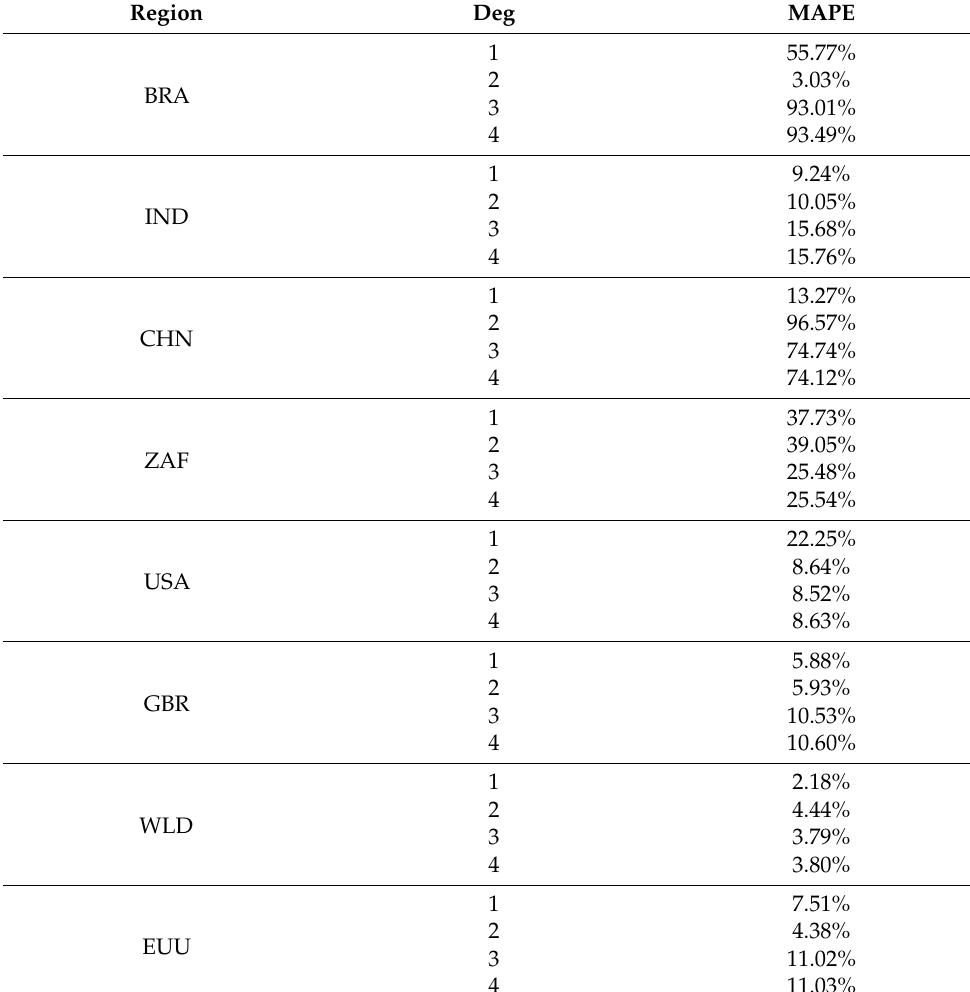
Table 8. Mean absolute percentage error (MAPE) on the test set using linear regression for different degrees of the polynomial (Deg). Region Deg